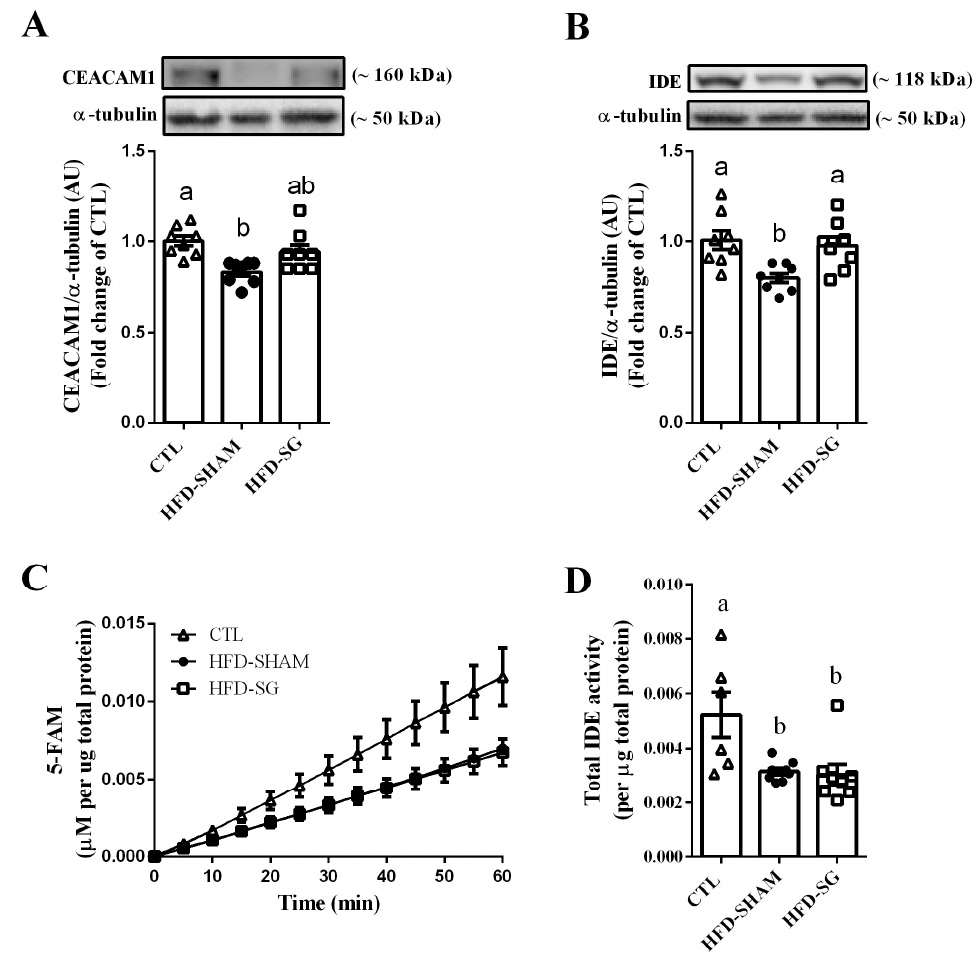
Figure 4. SG increases hepatic IDE expression but not IDE activity in HFD-SG mice. Protein expression of CEACAM1 ( A ) and IDE ( B ) in the liver of CTL, HFD-SHAM, and HFD-SG mice (n = 8). Kinetic of IDE activity assay ( C ) and total IDE activity ( D ) in the liver of CTL, HFD-SHAM, and HFD-SG mice (n = 6–8). Fluorescent intensity at Ex/Em = 490/520 nm was recorded every 5 min for 60 min. 5-Carboxyfluorescein (5-FAM) concentration was calculated using a standard curve and normalized per µ g of total protein. Data are the mean ± SEM. Different letters indicate statistical differences between groups, p ≤ 0.05 (one-way ANOVA or Kruskal–Wallis